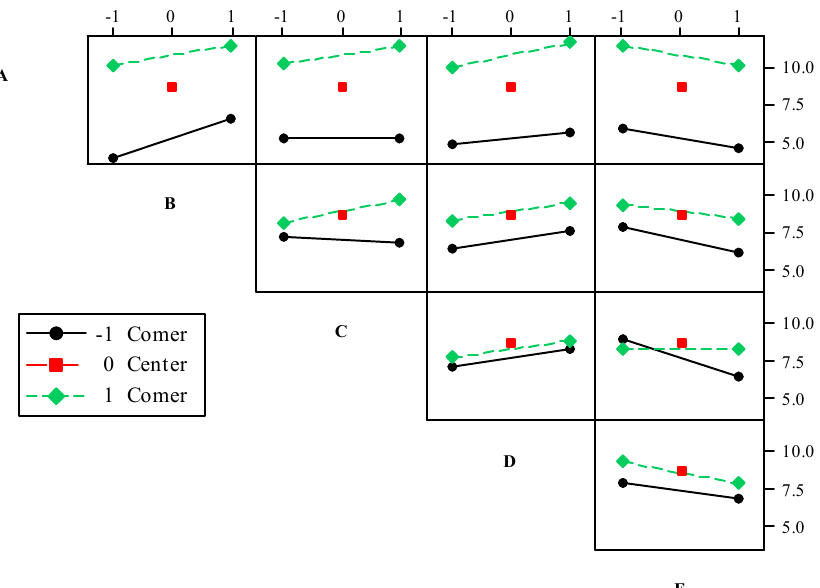
Figure 10. Interaction effects plot for Cd(II) removal: (A) pH, (B) Temperarure, (C) Time, (D) Cd(II) concentration, (E) NaCl.